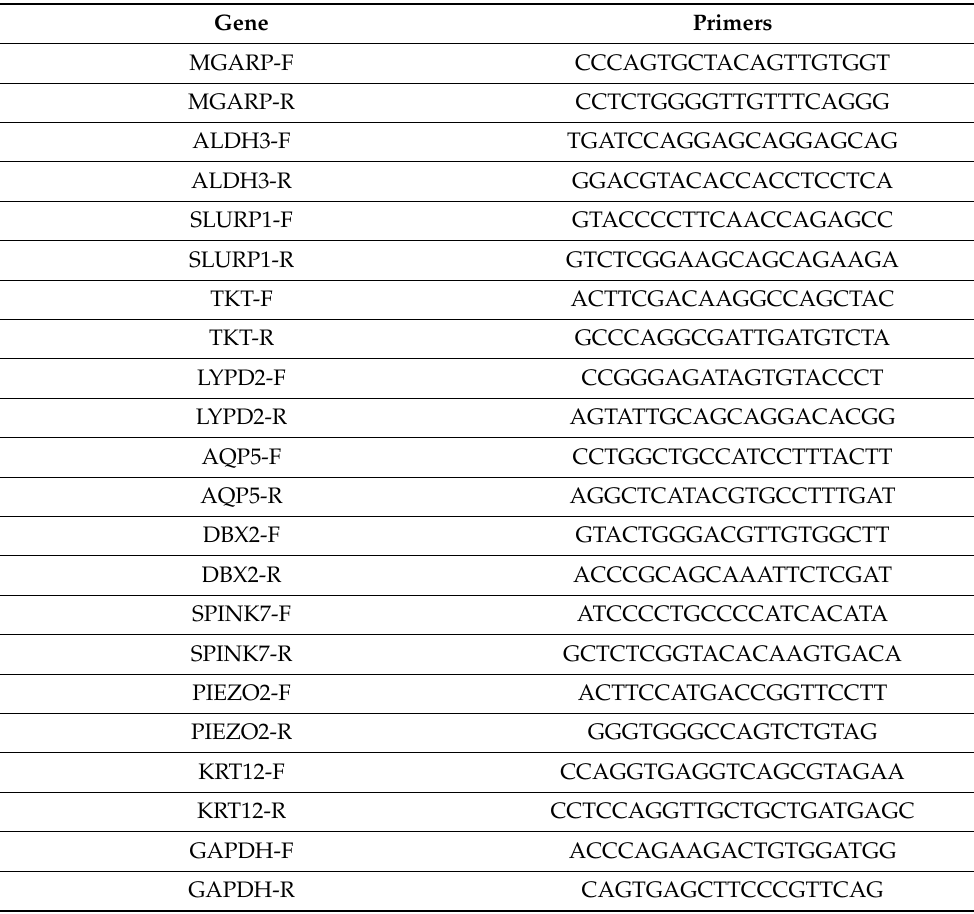
Table 1. Primers for Quantitative Real-Time